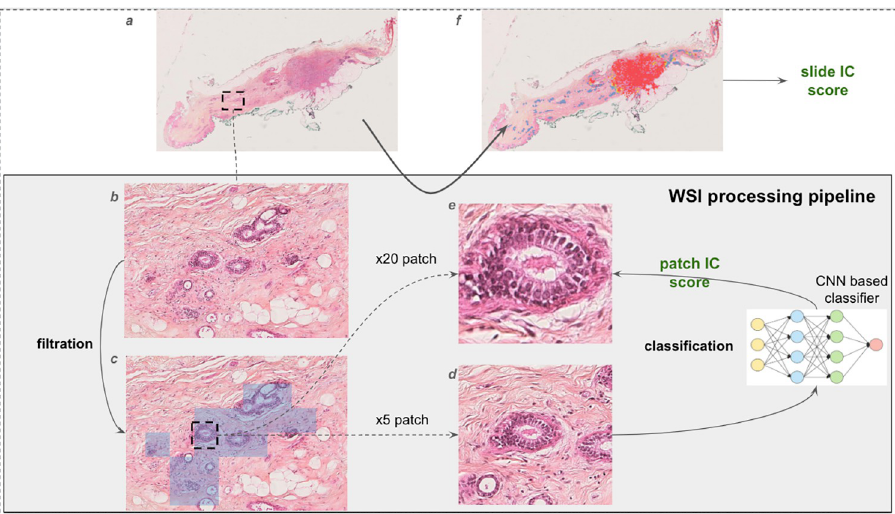
Fig 1. Whole slide image (WSI) processing pipeline for invasive carcinoma (IC) detection. This figure illustrates the processing pipeline for invasive carcinoma (IC) detection on breast WSI (a). A zoomed-in view of the tissue is shown in (b). Epithelial nuclear regions are first detected and parsed (c) into square patches at zoom x20 (e). For each x20 patch, an auxiliary patch with the same center and size is extracted at zoom x5 (d) and fed to a CNN based classifier to predict an IC score. This score is attributed to the x20 patch. The set of IC scores for x20 patches belonging to nuclear epithelial regions enables the location of cancer on a slide (f). Note that a patch is considered to fall into the IC class when its score is above a threshold determined through the ROC method. NB: the color code in (f) ranges from blue (very low IC score—low probability of IC) to red (very high IC score—high probability of IC). A slide IC score is then computed by taking the weighted average of the IC patches